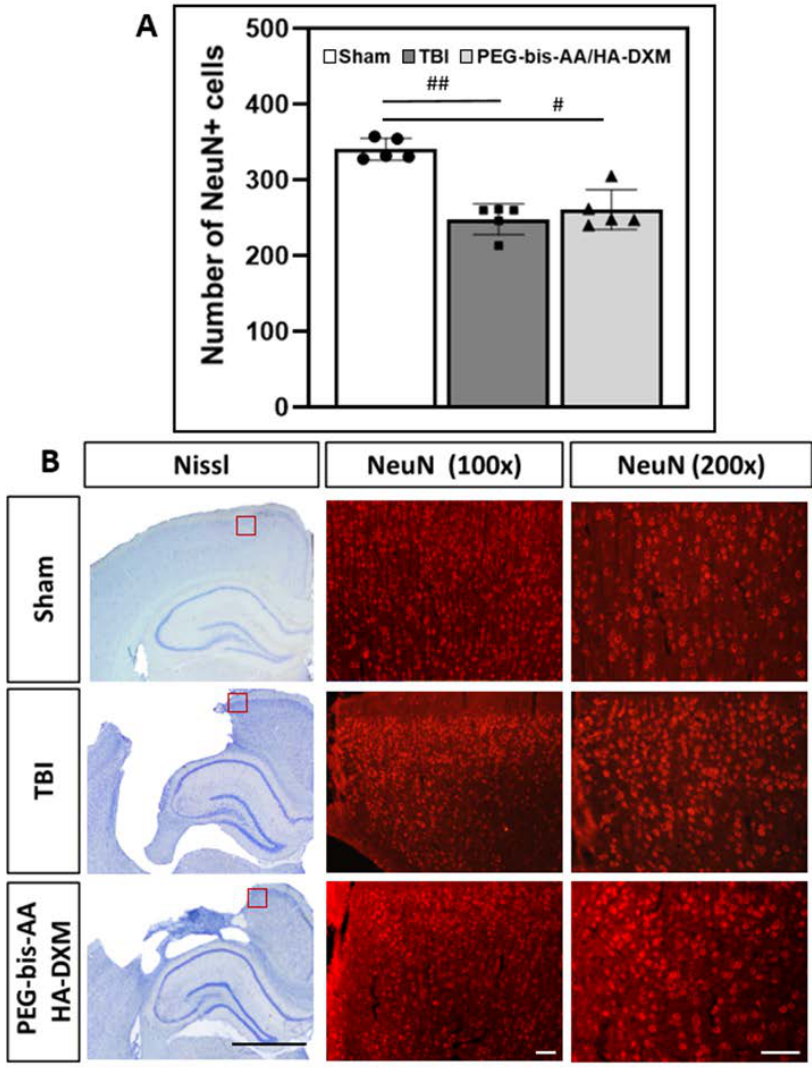
Figure 6. The effect of PEG-bis-AA/HA-DXM treatment on the apoptotic response at 14 DPI. ( A ) The average number of NeuN + neuronal nuclei is counted in the image area (total n = 15 sections; n = 3 sections/rat, n = 5 rats/group). Data are presented as mean ± STD. # p < 0.05 and ## p < 0.01 compared with sham. ( B ) Representative images of immunostaining for NeuN + neuronal nuclei in the ipsilateral cortex. Images captured in region indicated by the red box in the Nissl-stained brain sections (black scale bar represents 2 mm). White scale bars represent 100 µm.